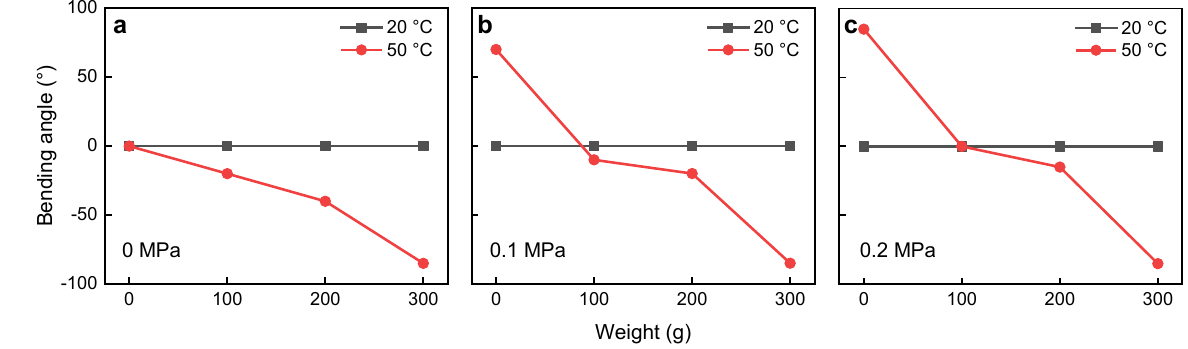
Figure 5. Bending performance of the actuator at different weights (0–300 g) at different temperature (20–50 ◦ C) when the pressure of input fluid is ( a ) 0 MPa, ( b ) 0.1 MPa, ( c ) 0.2 MPa..